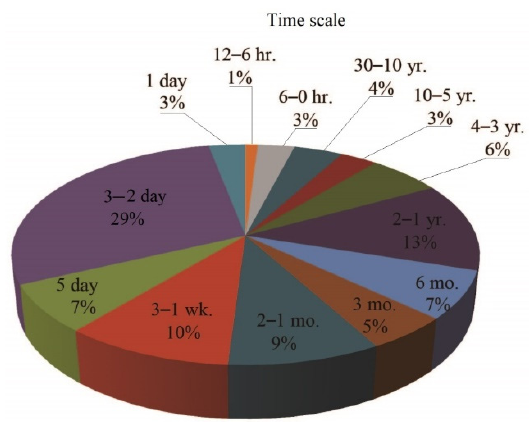
Figure 1. Temporal distribution of the appearance of all the reported anomalies (adapted from [33]).